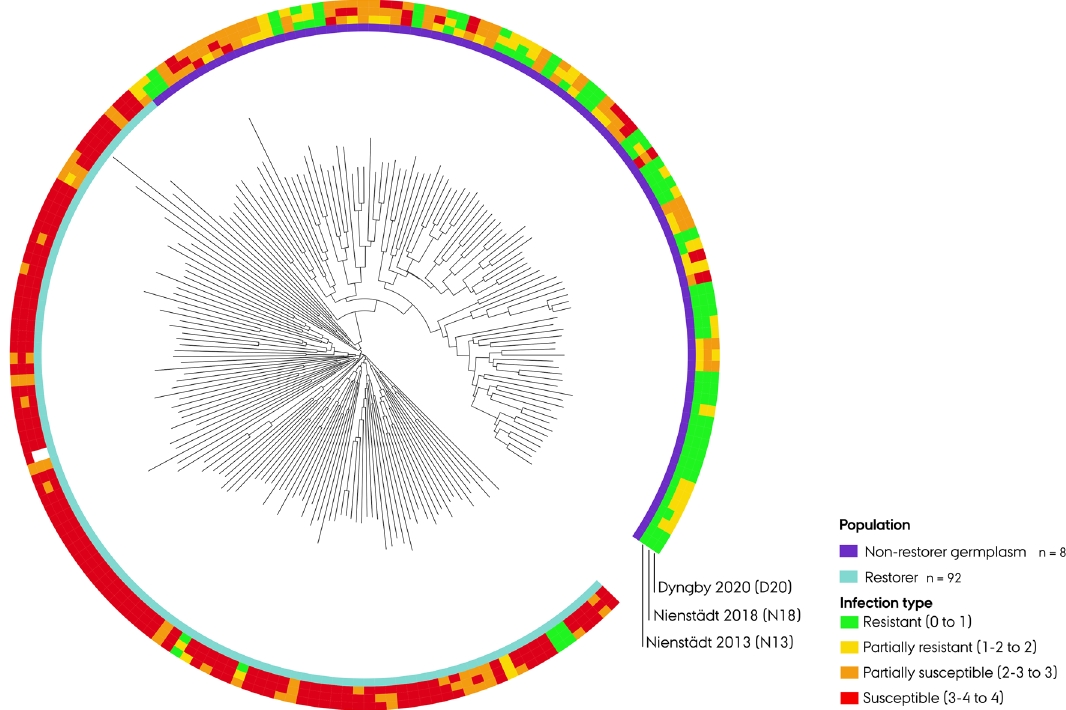
Figure 2. Circular neighbor-joining dendrogram of 180 hybrid rye ( Secale cereale L.) breeding lines. Infection type (0–4) reaction against three powdery mildew populations displayed by concentric circles around the dendrogram.